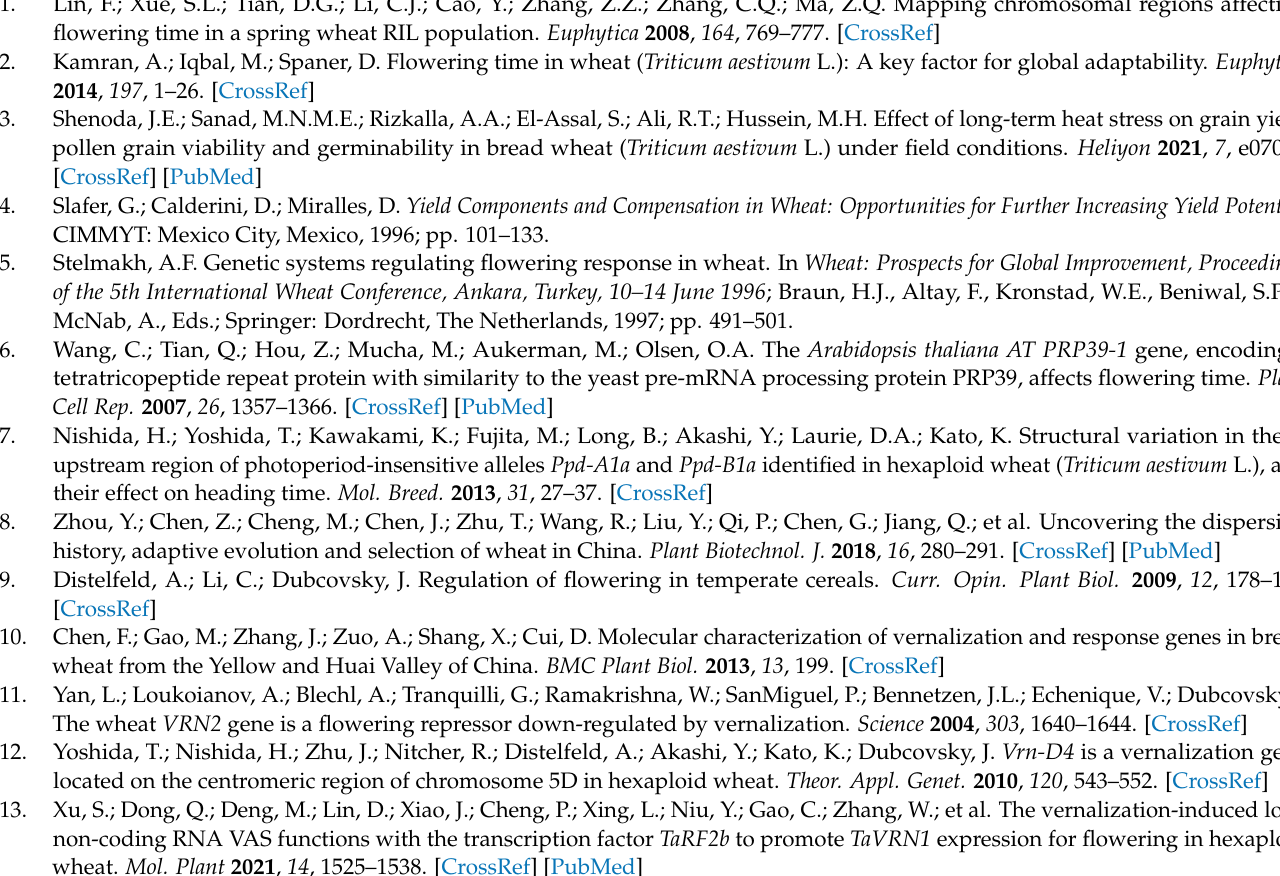
Table S1: SSR markers used in identification of chromosome constitution of 7B in CASL7BS, Table S2: Indel markers on chromosome 5A developed based on DNA resequencing, Table S3: Information of polymorphic SSR makers on chromosome 7B used for mapping the QTL related to heading date, Table S4: Information of indel markers developed based on resequenced sequences in the region of mapped HD-related QTL, Table S5: Genes in the region of QTL related to HD on Chinese Spring reference